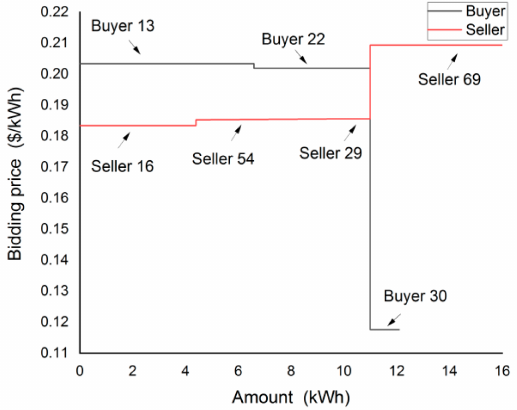
Figure 4. Bidding information at hour